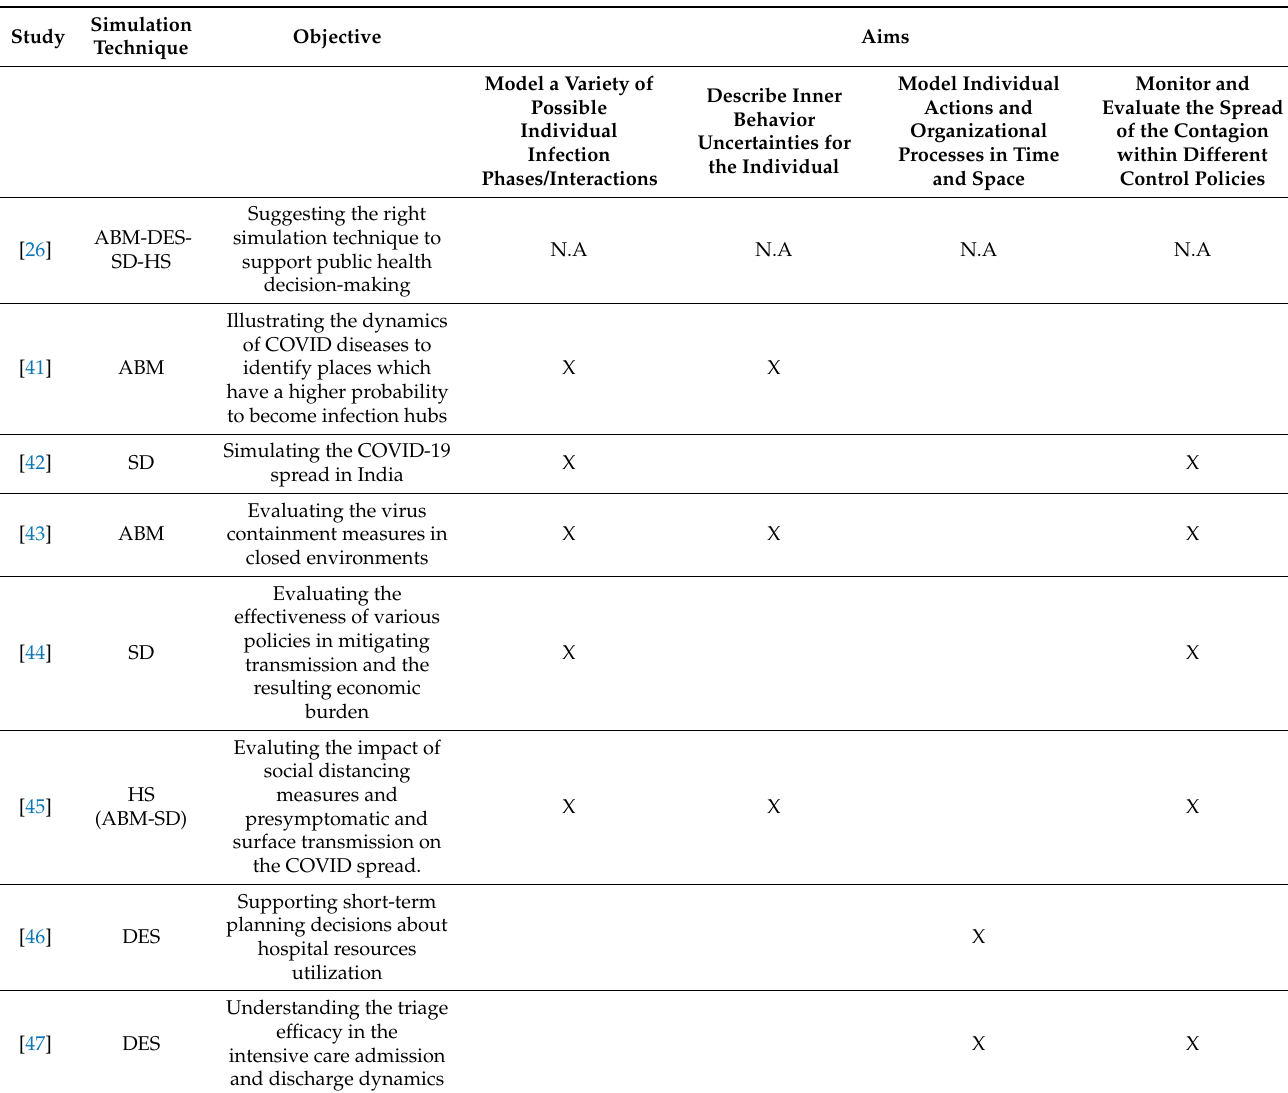
Table 3. Related works on simulation applied to COVID-19 pandemic.